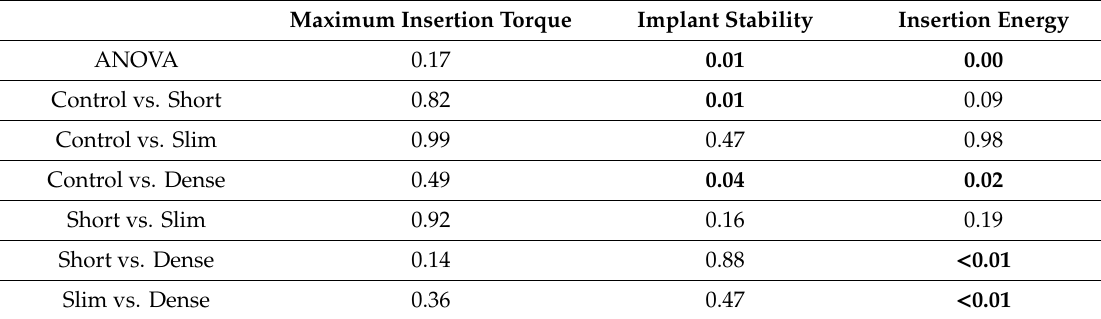
Table 3. Results ( p -values) of ANOVA and pairwise comparisons between the di ff erent implant systems used for all three parameters tested (Tukey’s honest di ff erences test; α = 0.05; significant di ff erences are written in